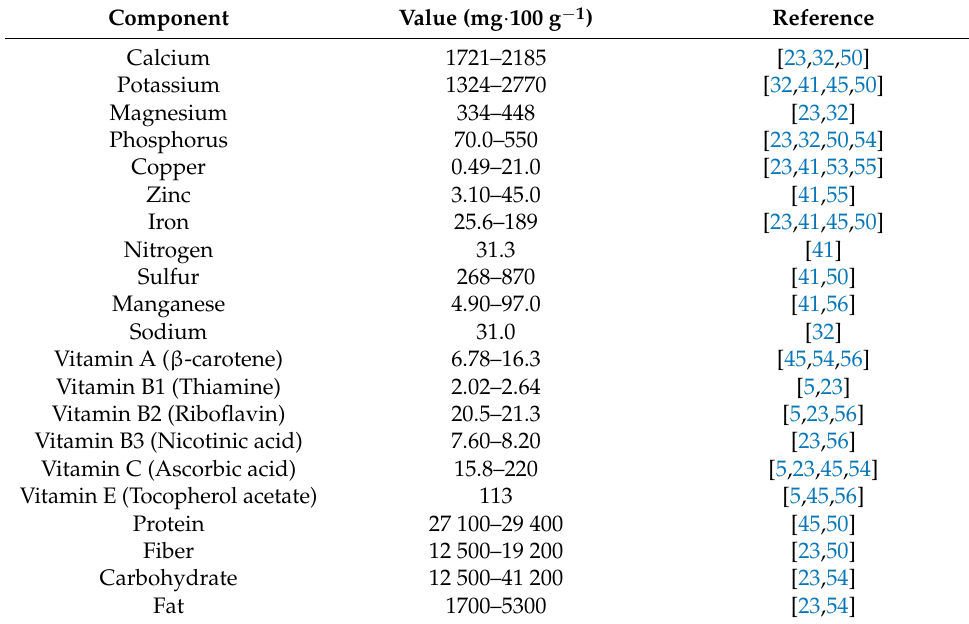
Table 2. The nutrient composition of dried moringa leaf powder.